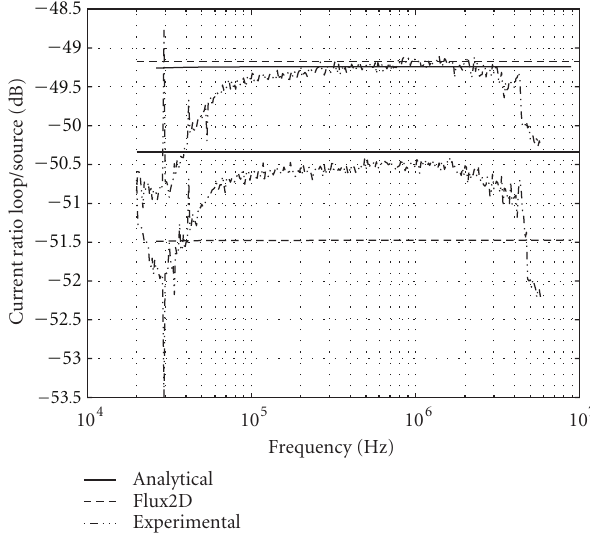
Figure 8: Transformer dB current ratio for all sensor loops.